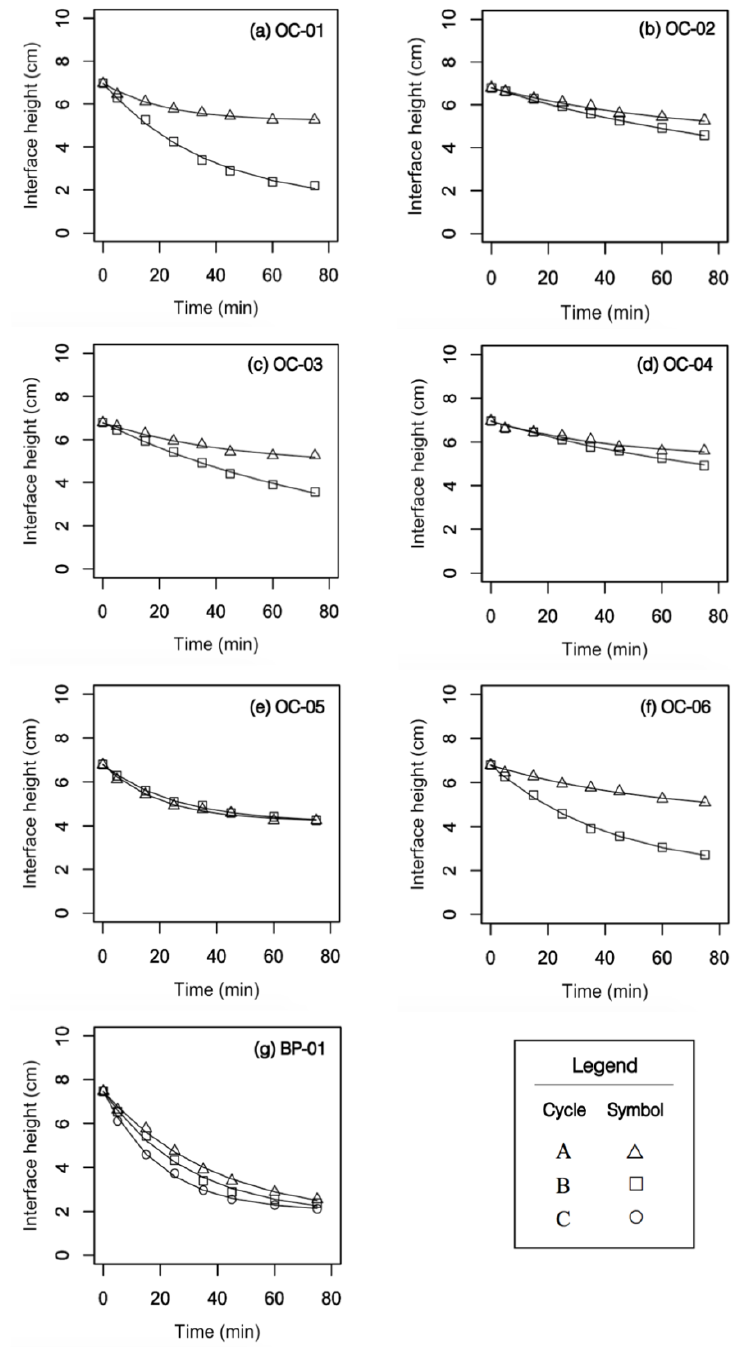
Figure 3. Plots of time course data for settling trials of Ogilvie Creek BIOS ( a – f ) and Beaver Pond BIOS samples ( g ) for cycles A (unshaken), B (shaken or resuspended), and an additional cycle C for BP-01 (resuspended), with corresponding best fit curves based on nonlinear estimation. In all cases, the fit accounts for greater than 97% of the variance in the observed settling heights ( R > 0.97).